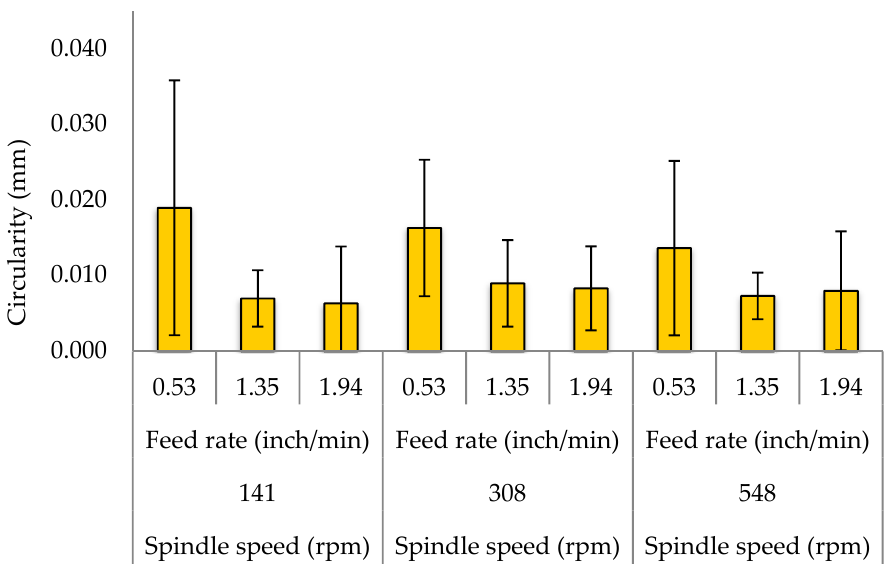
Figure 3. Circularity error. Table 2. ANOVA results.